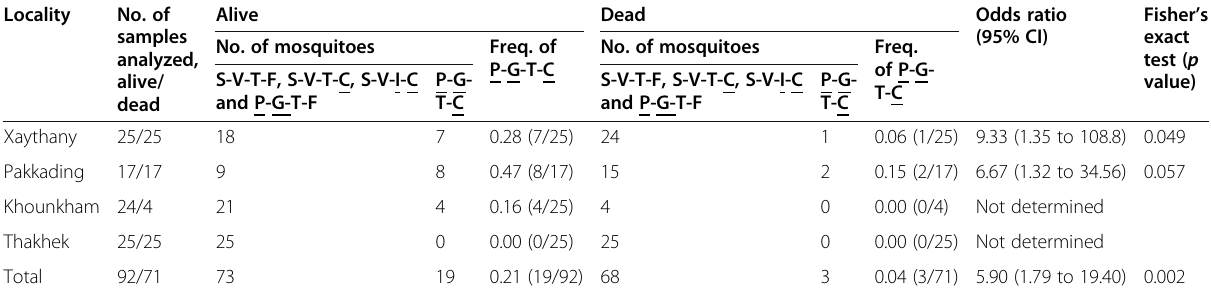
Table 5 Associations between the P-G-T-C haplotype and deltamethrin resistance among Ae. aegypti larvae collected from four populations